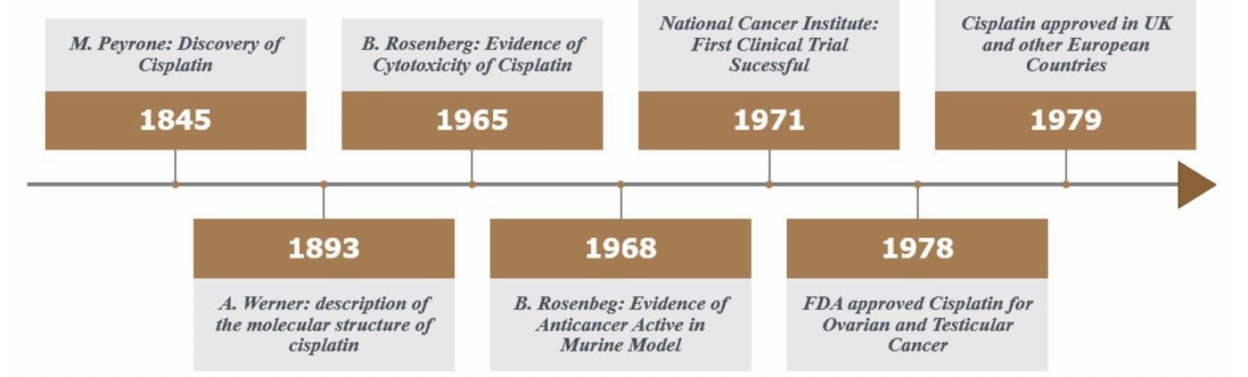
Figure 1. The timeline of cisplatin approval in United States and